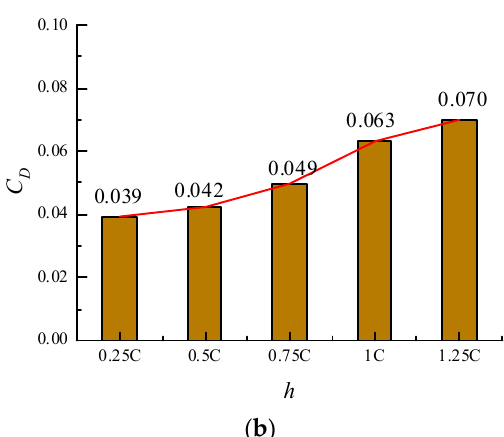
Figure 19. Comparison of the drag coefficient fluctuation and the average value at different water depths. ( a ) Drag coefficient fluctuations at different water depths; ( b ) Average drag coefficient at different water depths.